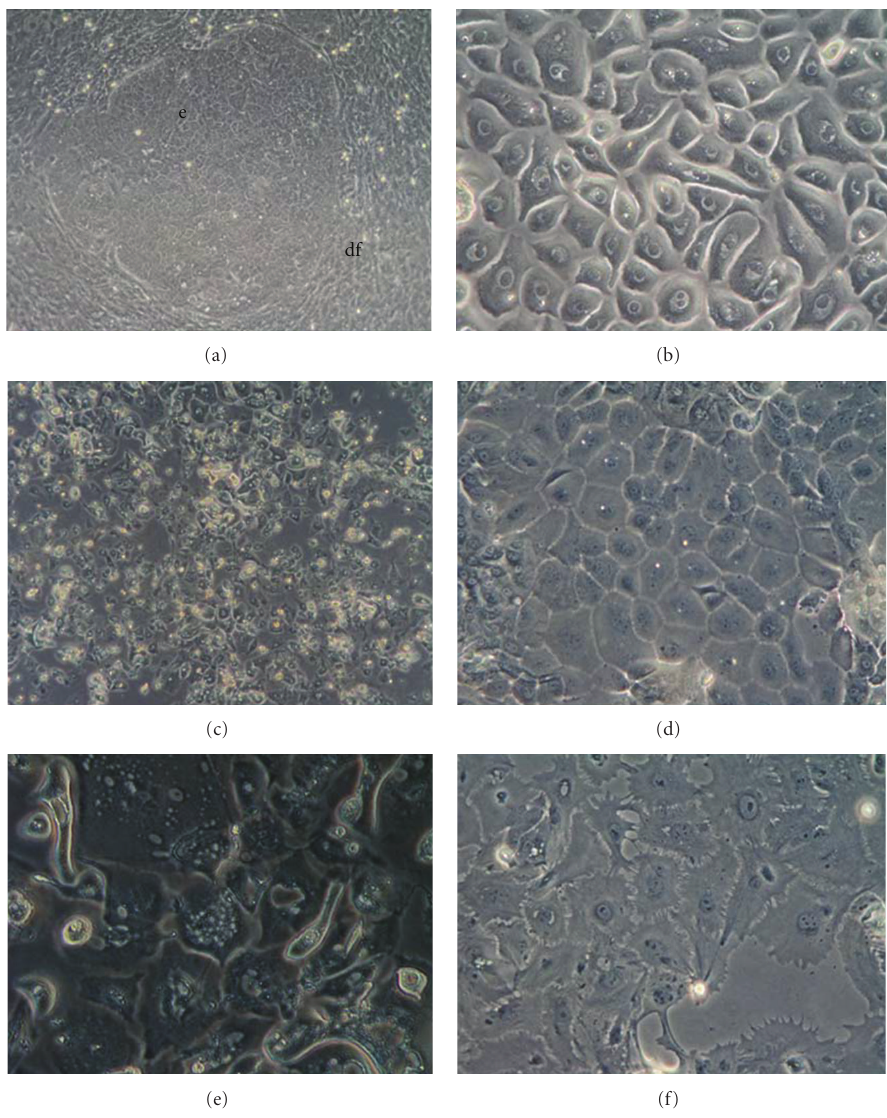
Figure 1: Phase-contrast micrographs. (a) Mixed culture of enamel organ-derived epithelial (EOE) cells and dental follicle cells after 1 week of culture. The epithelial cells (e) have formed an island within the strongly proliferating dental follicle cells (df). (b) EOE cells in LHC- 9 medium. After replacing the serum-medium with LHC-9, only EOE cells survived in the nonserum medium. The colony of EOE cells showed a cobblestone appearance associated with typical epithelial morphology. (c) Subcultured EOE cells (passage 1) grown on the insulin- like growth factor-I/insulin-like growth factor binding protein-3/vitronectin complex after 10 days of cultivation. (d) EOE cells cultured on insulin-like growth factor-I/insulin-like growth factor binding protein-3/vitronectin (IGF-IGFBP-VN) complex. After 1 passaged, EOE cells had the same characteristic morphology. After 25 days of cultivation, the colony became confluent. The EOE cells had the same characteristic morphology. (e) EOE cells cultured on collagen type I-coated dishes. The cells showed a vague outline and expanded morphology. (f) EOE cells cultured on PS. The EOE cells displayed on extended morphology. Scale bars: 100 μ m (a), 50 μ m (b–d)